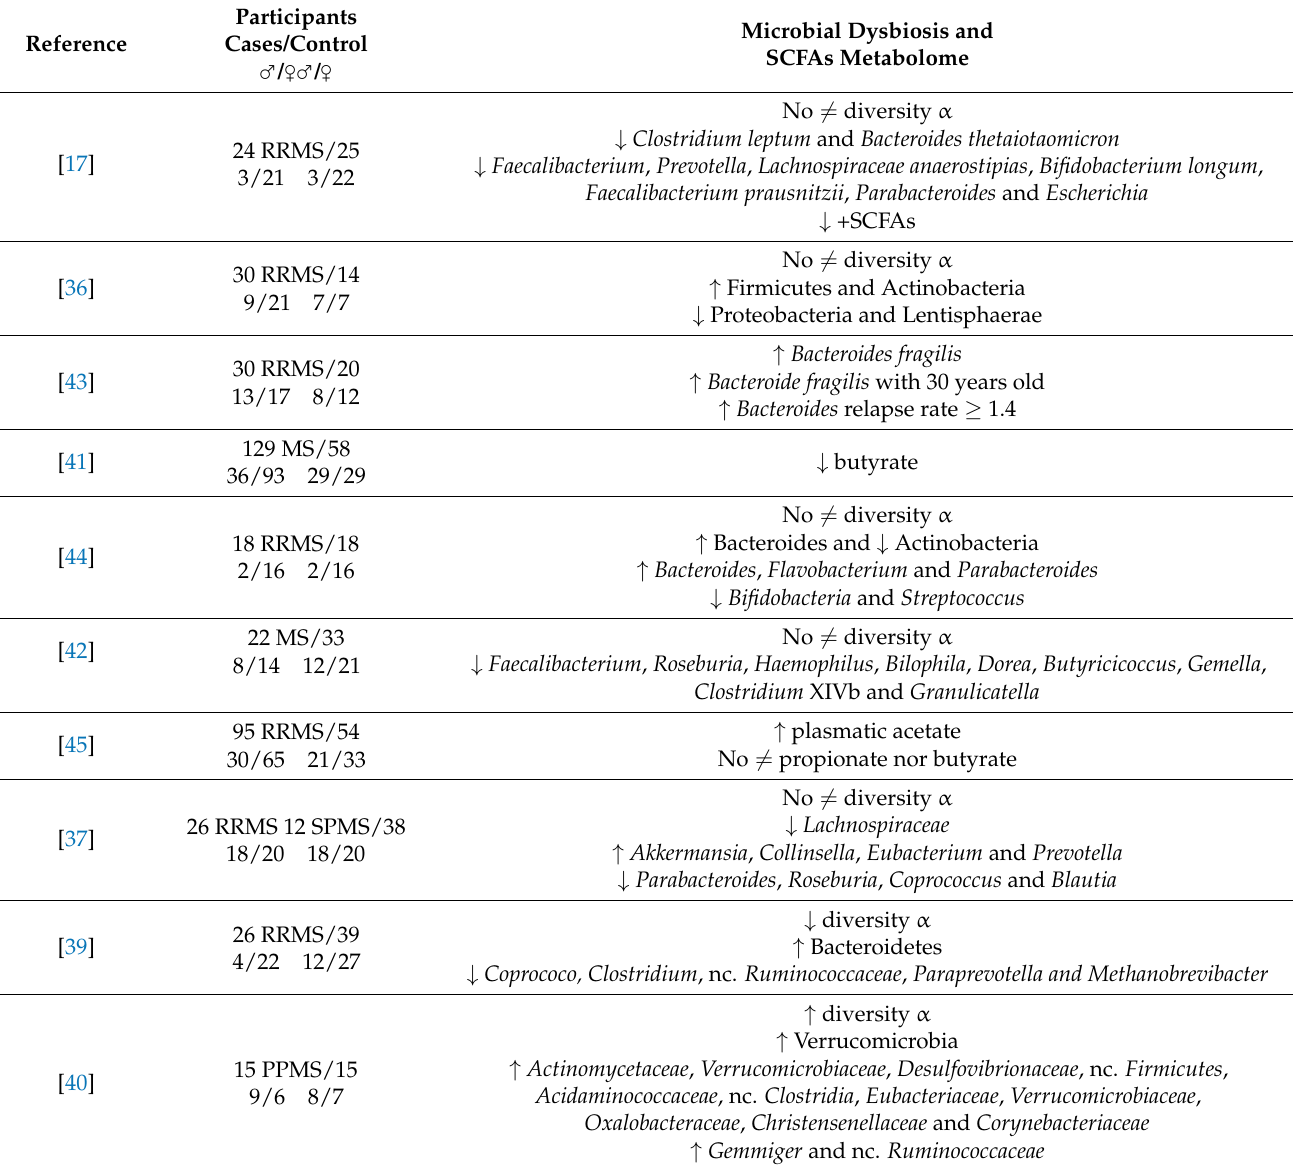
Table 2. Summary of the articles included in the